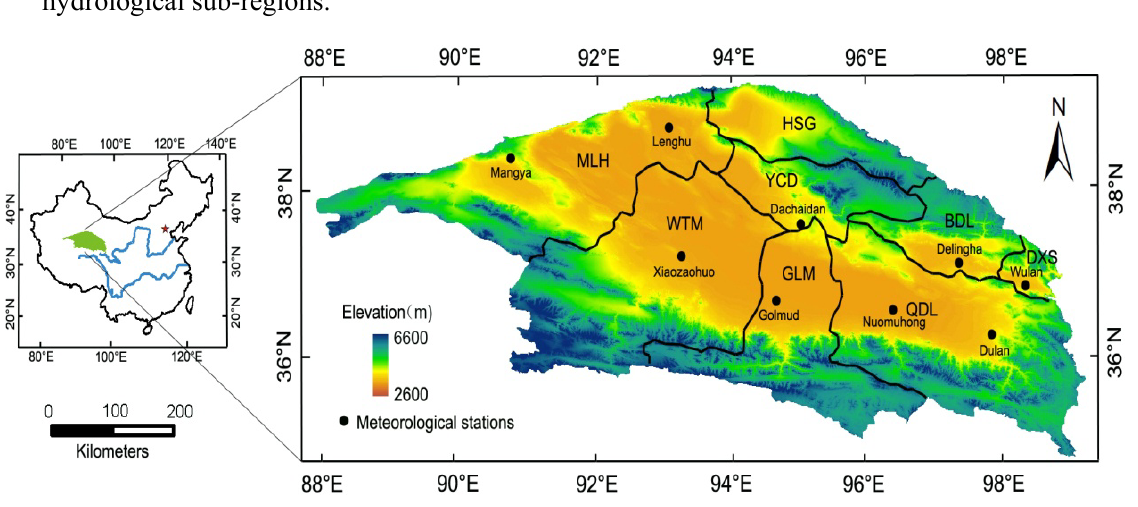
Figure 1. Location of Qaidam Basin and eight hydrological sub-regions. The black points represent the meteorological stations and the black solid lines are the boundary of hydrological